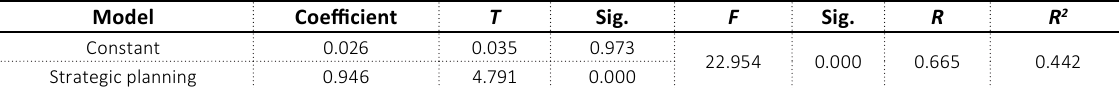
Table 6. The impact of strategic planning on the customer perspective Model